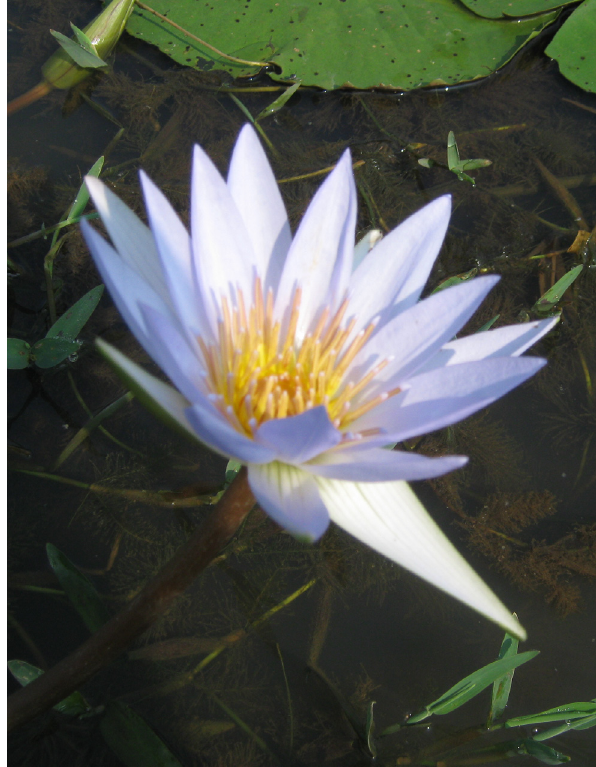
Fig. 14. Flowering twig of Nymphaea stellata var. major F. Muel-